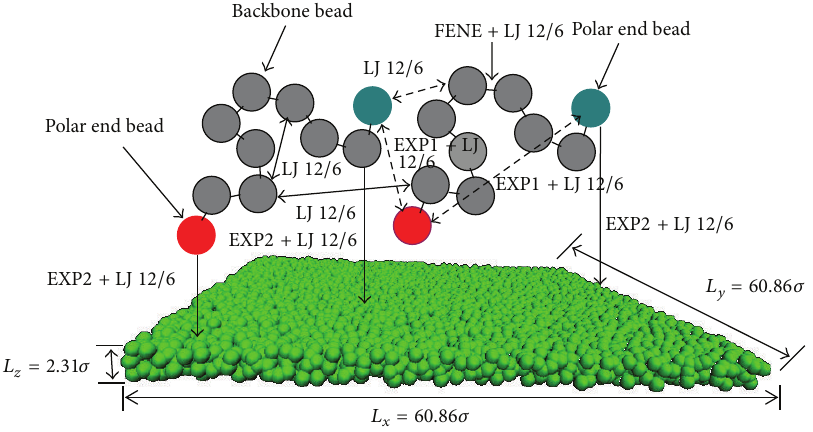
Figure 2: Coarse-grained bead spring model of functional lubricant PFPE Zdol on a DLC thin film